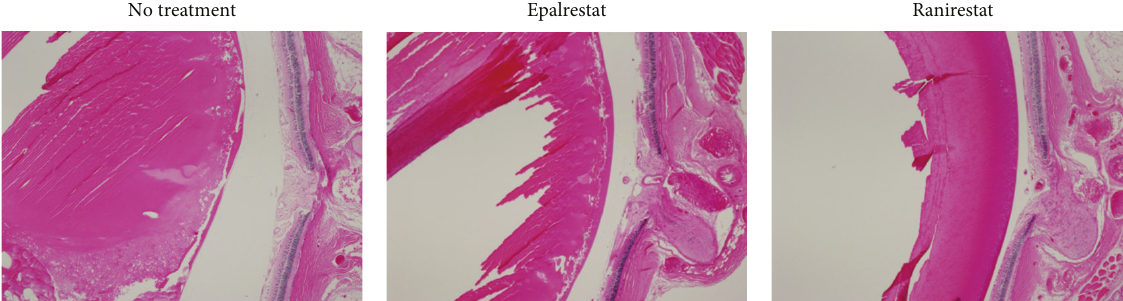
Figure 15: Pathology (hematoxylin, original magnification 4x) at 40 weeks. In an untreated eye (left), the lens has a sclerotic nucleus floating in liquefied cortex and vacuolation and disintegration of cortex fibers. In the epalrestat-treated eye (middle), the findings are virtually the same as in the untreated eye. In the ranirestat-treated eyes (right), the eye has an almost normal lens and retina.